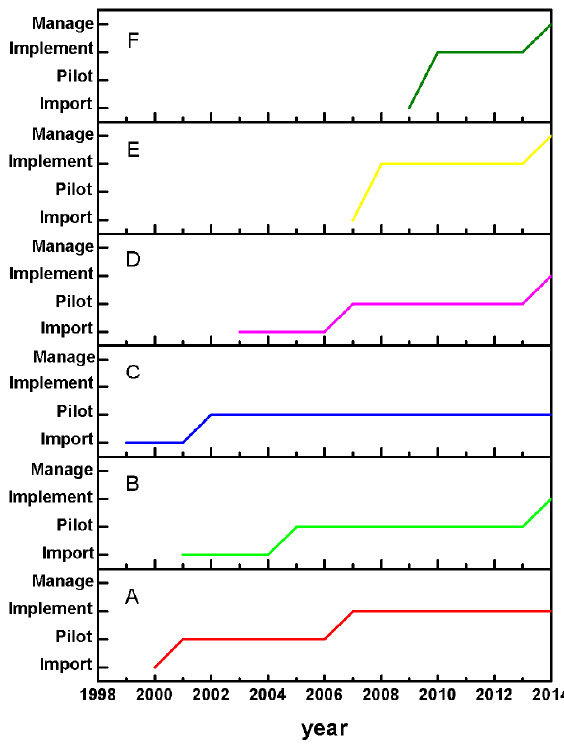
Figure 4. Differentiating the development speed in six provinces. A—Beijing, B—Hebei Province, C—Shandong Province, D—Shanxi Province, E—Gansu Province, F—Xinjiang Province.